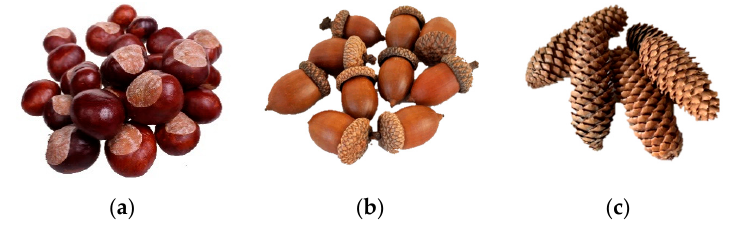
Figure 2. Organic materials used in the studies: ( a ) horse chestnuts; ( b ) oak acorns; and ( c ) spruce cones.